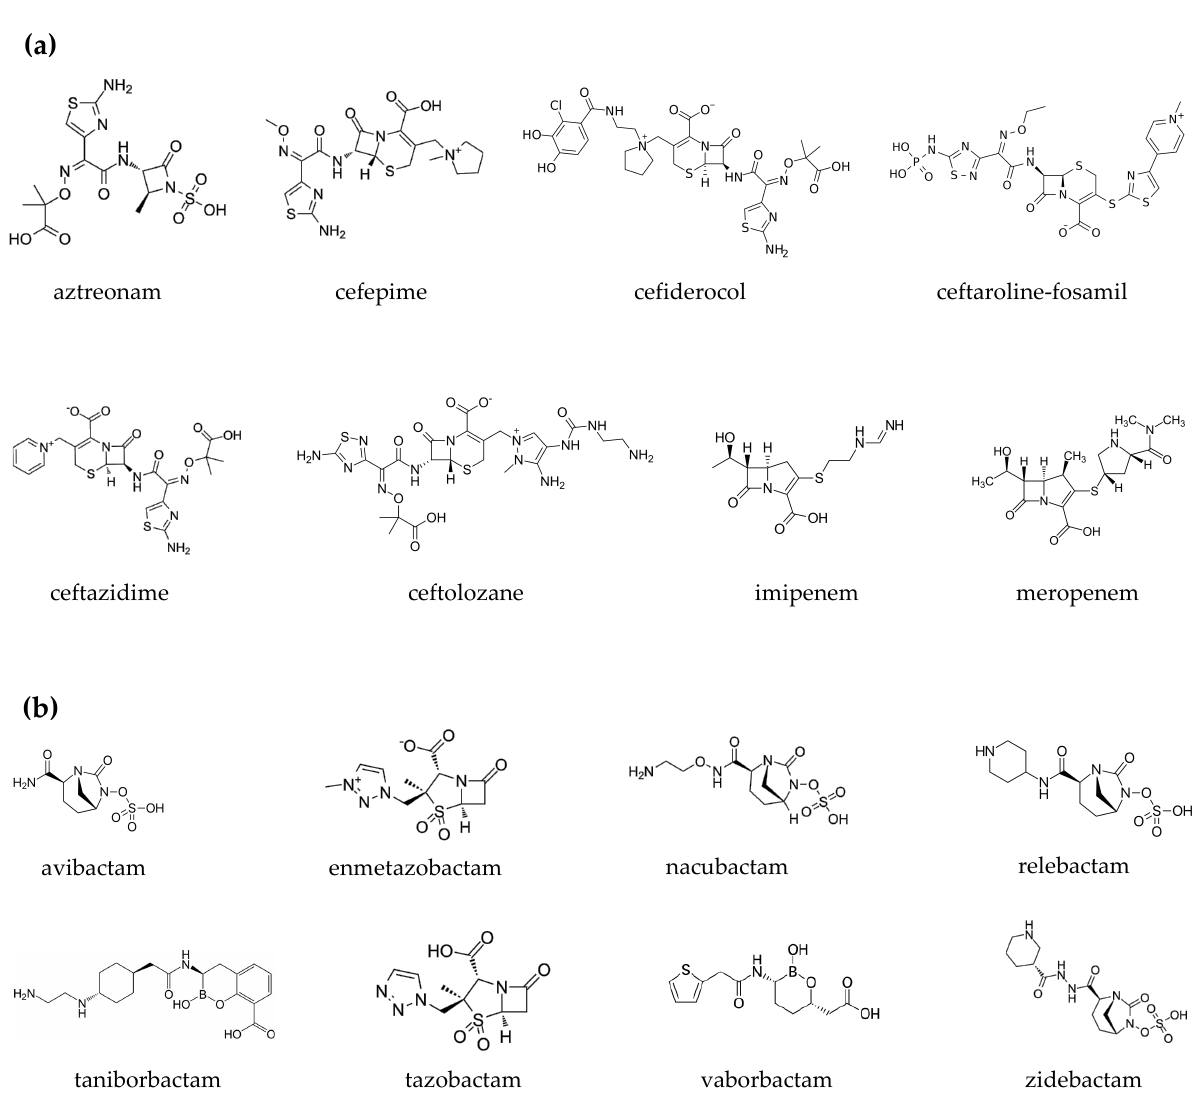
Figure 1. Chemical structures of ( a ) β -lactams and ( b ) β -lactamase inhibitors. Currently, seven clinical trials on aztreonam/avibactam are registered: five are com- pleted and two are recruiting. The efficacy of the combination is being tested in patients with bloodstream infections (BSIs), complicated intra-abdominal infections (cIAIs), compli- cated urinary tract infections (cUTIs), hospital-acquired pneumonia (HAP), and ventilator- associated pneumonia (VAP). In contrast, aztreonam/avibactam safety is more generally being evaluated in patients with serious or complicated bacterial infections [5]. Recently, a phase 2 trial was published: 34 patients with cIAIs were treated for 5–14 days with aztre- onam/avibactam + metronidazole. No patients had either ESBL or MBL-positive isolates. Patients were divided into three cohorts: (1) 500/137 mg, followed by 1500/410 mg every 6 h; (2) 500/167 mg, followed by 1500/500 mg every 6 h; and (3) extension of exposure at the higher dose regimen. The most common adverse events were hepatic enzyme increases (26%) and diarrhea (15%). Clinical cure rates at the test-of-cure visit were 59% overall [6]. Data from this study supported the regimen selected for the phase 3 trial (500/167 mg, followed by 1500/500 mg every 6 h) (Table